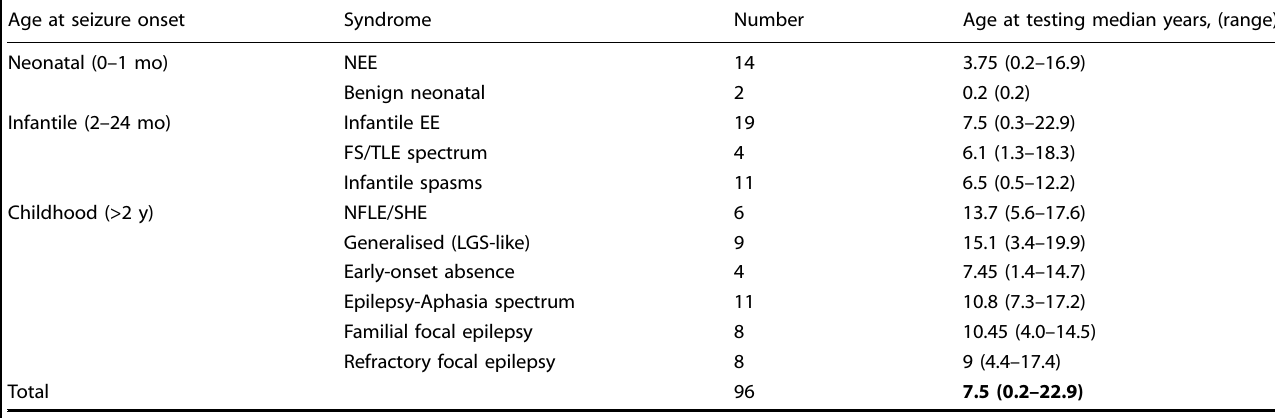
NEE neonatal epileptic encephalopathy (epilepsy with onset between birth and 3 months of age), IEE infantile epileptic encephalopathy (epilepsy with onset between 4 and 12 months), GEFS generalised epilepsy with febrile seizures (https://www.epilepsydiagnosis.org/syndrome/fbp-overview.html), TLE temporal lobe epilepsy (https://www.epilepsydiagnosis.org/syndrome/other-familial-temporal-lobe-overview.html), NFLE nocturnal frontal lobe epilepsy also known as SHE sleep-related hypermotor Epilepsy, 37 LGS Lennox – Gastaut syndrome